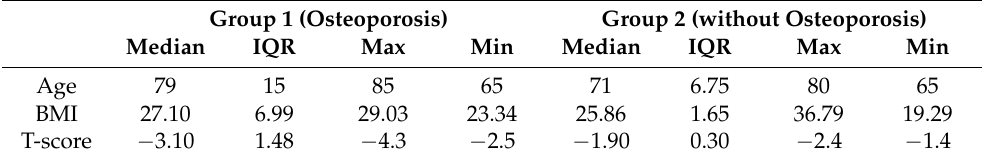
Table 1. Participants’ age, body mass index (BMI), and